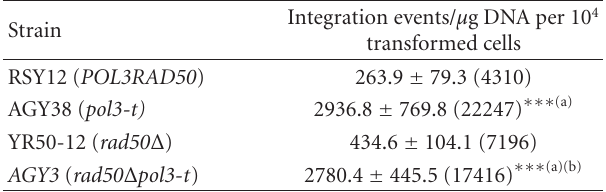
Table 3: E ff ect of pol3-t on homologous integration in Saccha- romyces cerevisiae . Homologous gene targeting was measured by transformation of the plasmid pJZ102 digested with Eco RI- Hind III to release a URA3 fragment that was flanked by the 5 (cid:2) and 3 (cid:2) ends of LYS2 gene. Only URA3lys2 colonies were counted as homologous integrants. In parentheses, the total URA3lys2 colonies counted are reported. Data are reported as mean of at least 6 independent experiments ± standard deviation.